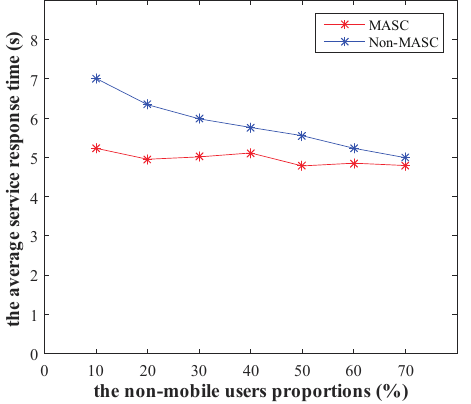
Figure 12. Performance comparison under different non-mobile user proportions ( z p =